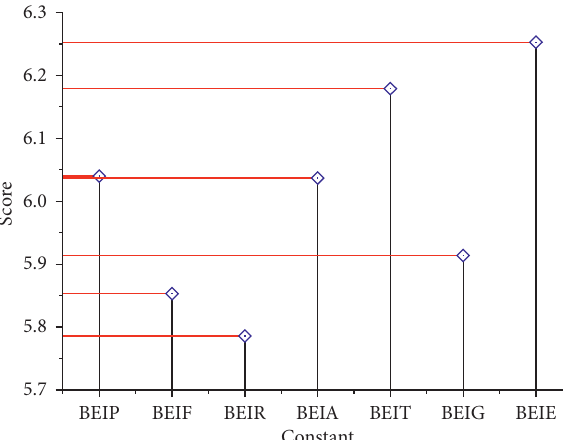
Figure 5: Evaluation index scores of the music education informatization level.